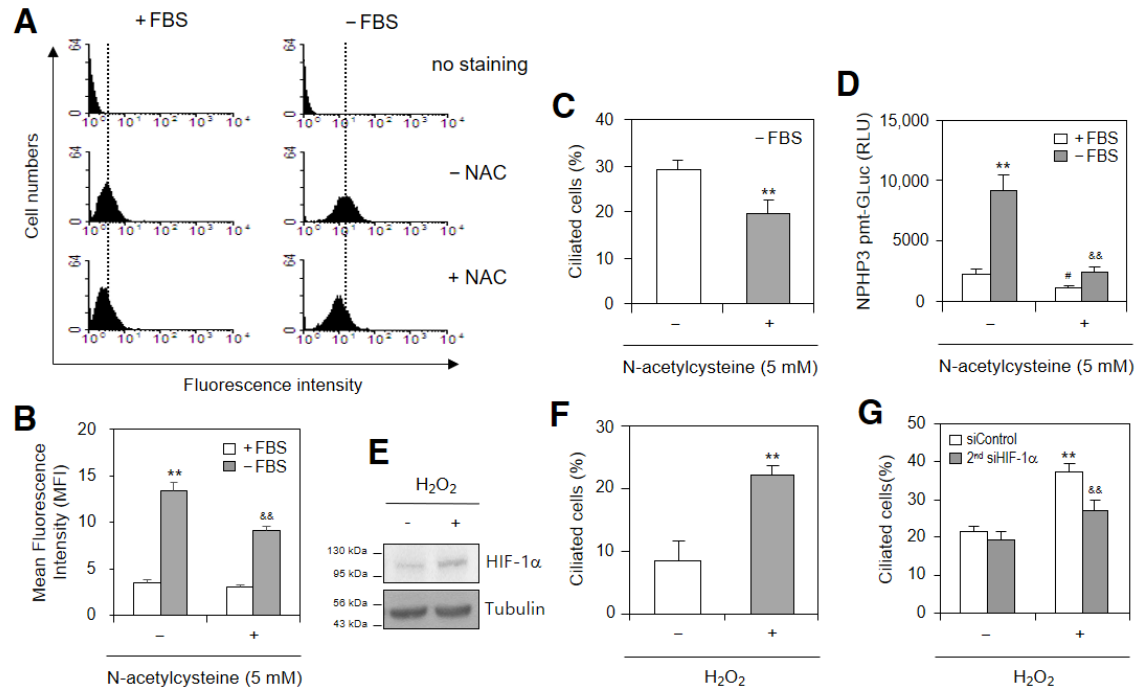
Figure 4. Primary cilium formation was enhanced by reactive oxygen species (ROS) and HIF-1 α under serum-deprived (SD) condition. ( A , B ) Cells were incubated under SD condition in the ab- sence or presence of N-acetylcysteine (NAC) and treated with DCF-DA. Fluorescent cells with ROS production were measured by FACS analysis ( A ). Geometric mean fluorescence intensity (MFI) from four experiments was analyzed by WinMDI 2.8 ( B ). The differences in MFI were indicated by grey dotted or solid lines. ( C ) Cells were incubated under SD condition in the absence or presence of NAC. The cells were fixed and stained with antibody against Ac-tubulin. The representative im- age of primary cilia was observed with 400× magnification under fluorescence microscope. The cil- iated cells ( n > 500 cells) in NAC-untreated (white) or -treated (grey) groups were counted. ( D ) Cells were transfected with pEZX-PG02-NPHP3-promoter-Gluc plasmids and incubated in the absence or presence of NAC for 24 h. The activity of Gluc in cultured media was measured with luminometer using Gluc substrate. ( E ) Cells were treated wi th 50 μM H 2 O 2 for 24 h. Cell lysates were prepared and HIF-1 protein was detected by Western blot analysis. ( F , G ) Cells were treated with 50 μM H 2 O 2 for 24 h ( F ) after the inhibition of HIF-1 by the transfection of siHIF-1 ( G ). The cells were fixed and stained with antibody against Ac-tubulin. The primary cilium was observed with 1000× magnification under fluorescence microscope. The ciliated cells ( n > 500 cells) were counted in each group. Data were the representatives of four experiments. Data in bar graphs represent the means ± SD ( B – D , F , G ). * p < 0.05, ** p < 0.01; significantly different from FBS-treated ( B , D ) or NAC-un- treated ( C ) or H 2 O 2 – untreated ( F , G ) control group. # p < 0.01; significantly different from NAC-un- treated group with FBS ( D ). && p < 0.01; significantly different from SD control and NAC-untreated ( B , D ) or H 2 O 2 -treated and control-siRNA-treated group ( G ). 2.4. ROS-Increased ERK Is Related to PC Formation and NPHP3 Transcription As ERK is a ROS-induced kinase that regulates HIF-1 in the expression of various genes [37,38], we tested whether ROS-increased ERK was related to PC formation and NPHP3 transcription. As SD increased ERK phosphorylation ≈ 2.4 times (Figure 5A) that was decreased ≈ 85% with the NAC treatment (Figure 5B), we confirmed the increase of ROS-mediated ERK phosphorylation ≈ 3.2 times in the H 2 O 2 -treated group (Figure 5C). We also examined the role of ERK in PC formation and NPHP3 transcription using PD98059